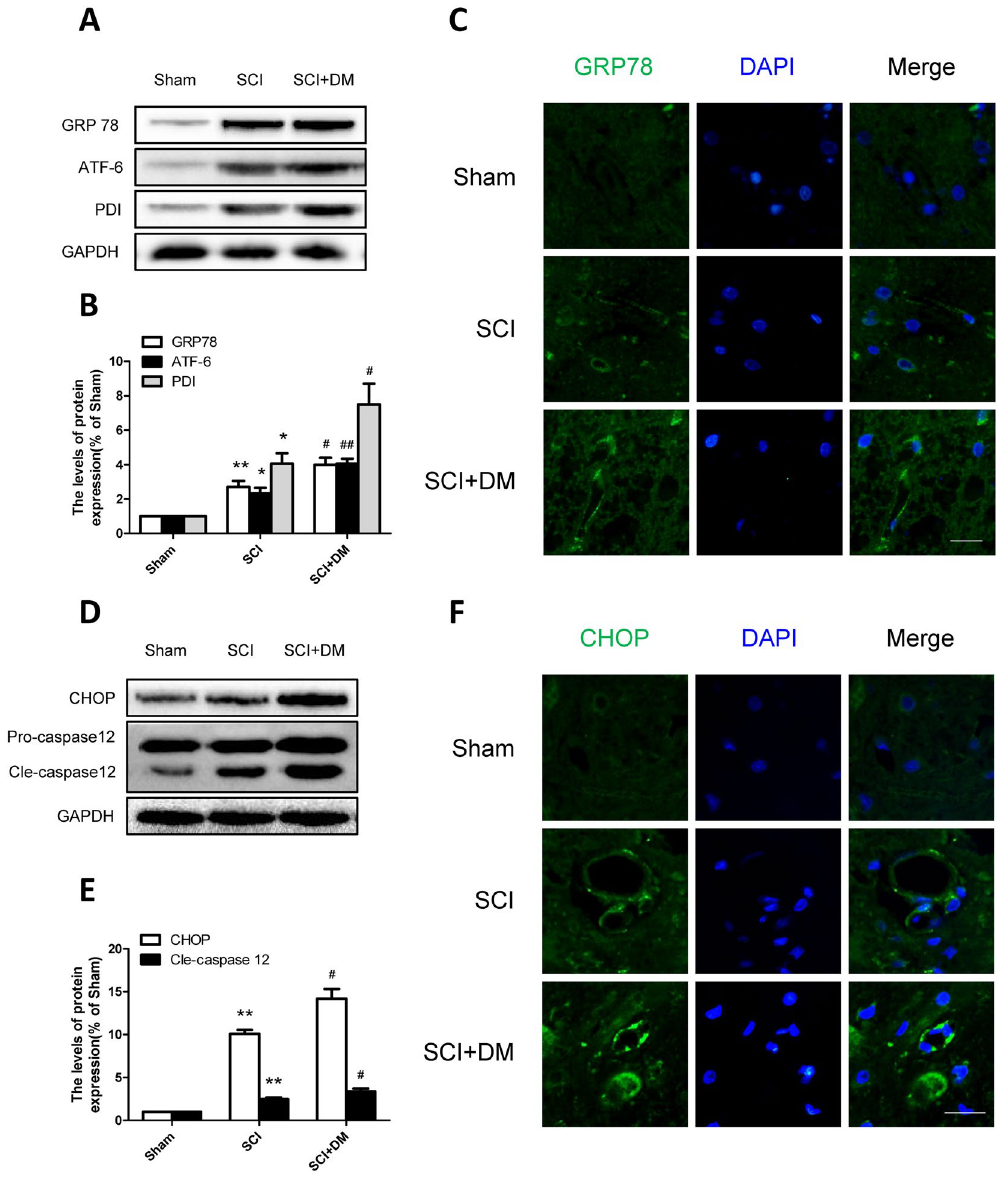
Figure 4. DM exacerbates the activation of ER stress after SCI. ( A , B ) Western blot and quantification of GRP78, ATF-6 and PDI in each group, n = 6. ( C ) Immunofluorescence staining of GRP78 in each group, n = 4. Scale bar = 10 μ m. ( D , E ) Western blot and quantification of CHOP and caspase12 in each group, n = 6. ( G , H ) Immunofluorescence staining of CHOP in each group, n = 4. Scale bar = 10 μ m. * p < 0.05, ** p < 0.01 vs sham group, # p < 0.05, ## p < 0.01 vs SCI